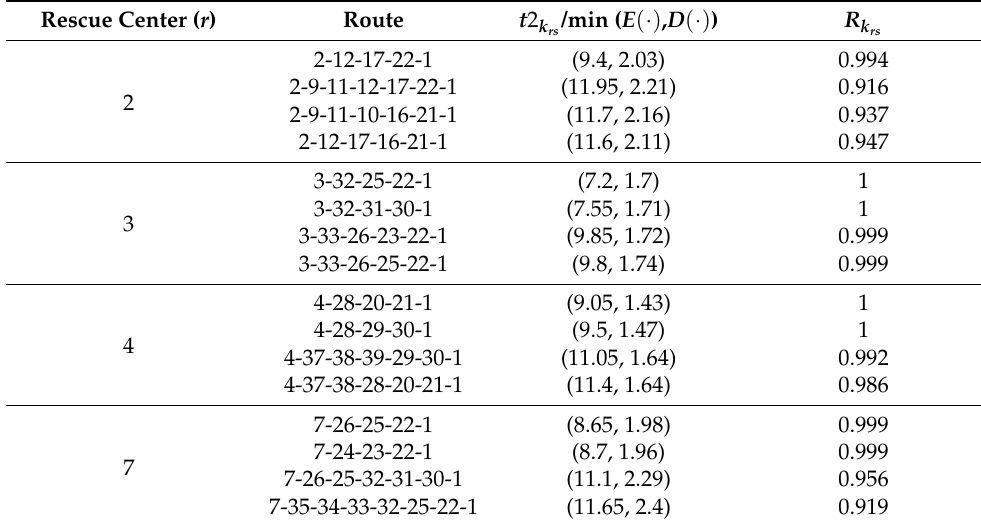
Table 8. Feasible routes and their reliability for rescue resource 1.